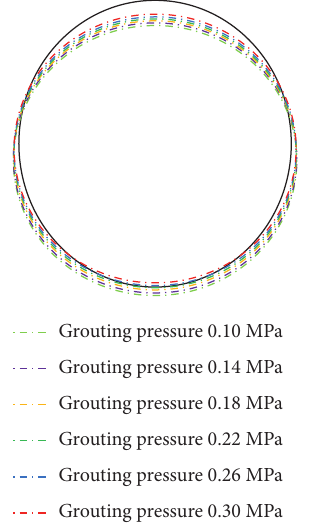
Figure 7: Segment deformation under different grouting pressures.